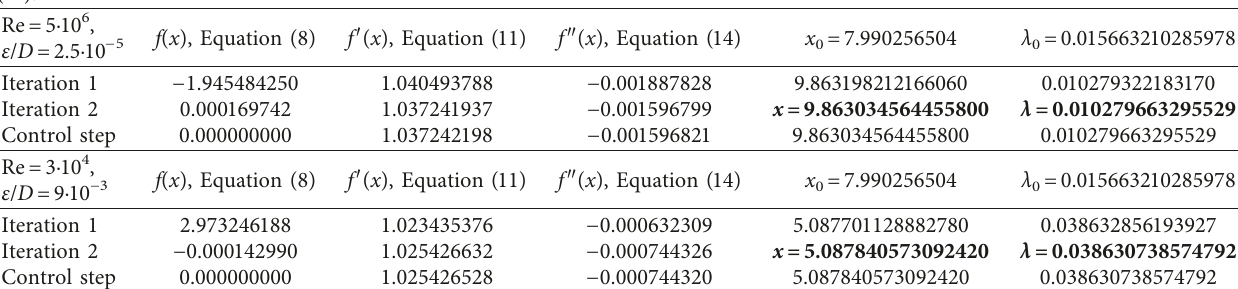
Table 7: Schr¨oder procedure. Option 7: fixed initial starting point x indirect calculation of λ through the transmission factor x : Equation (17), and the symbolic derivatives f ′ ( x ) and f ″ ( x ): Equations (11) and (14).